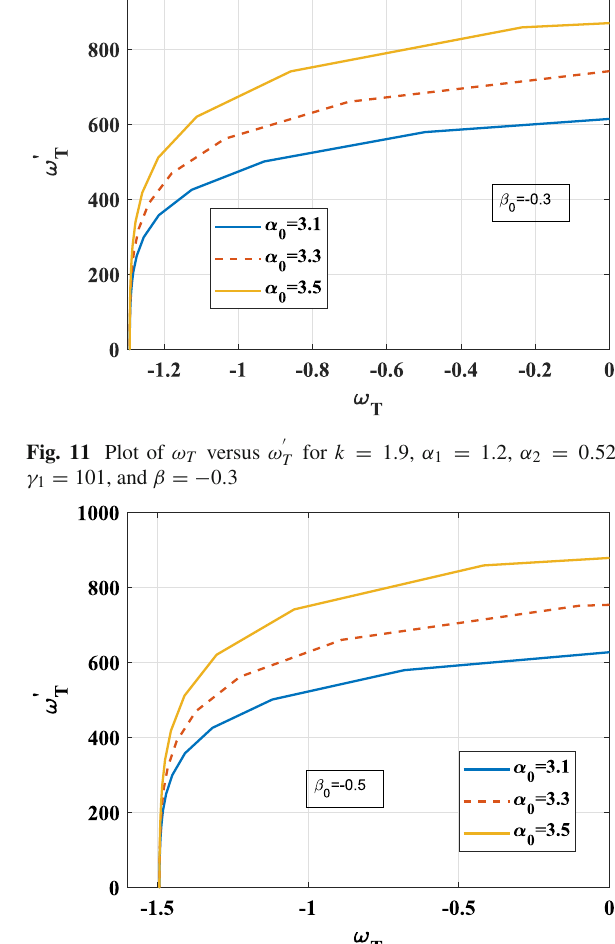
Fig. 12 Plot of ω T versus ω (cid:2) γ = 101, and β = − 0 . 1